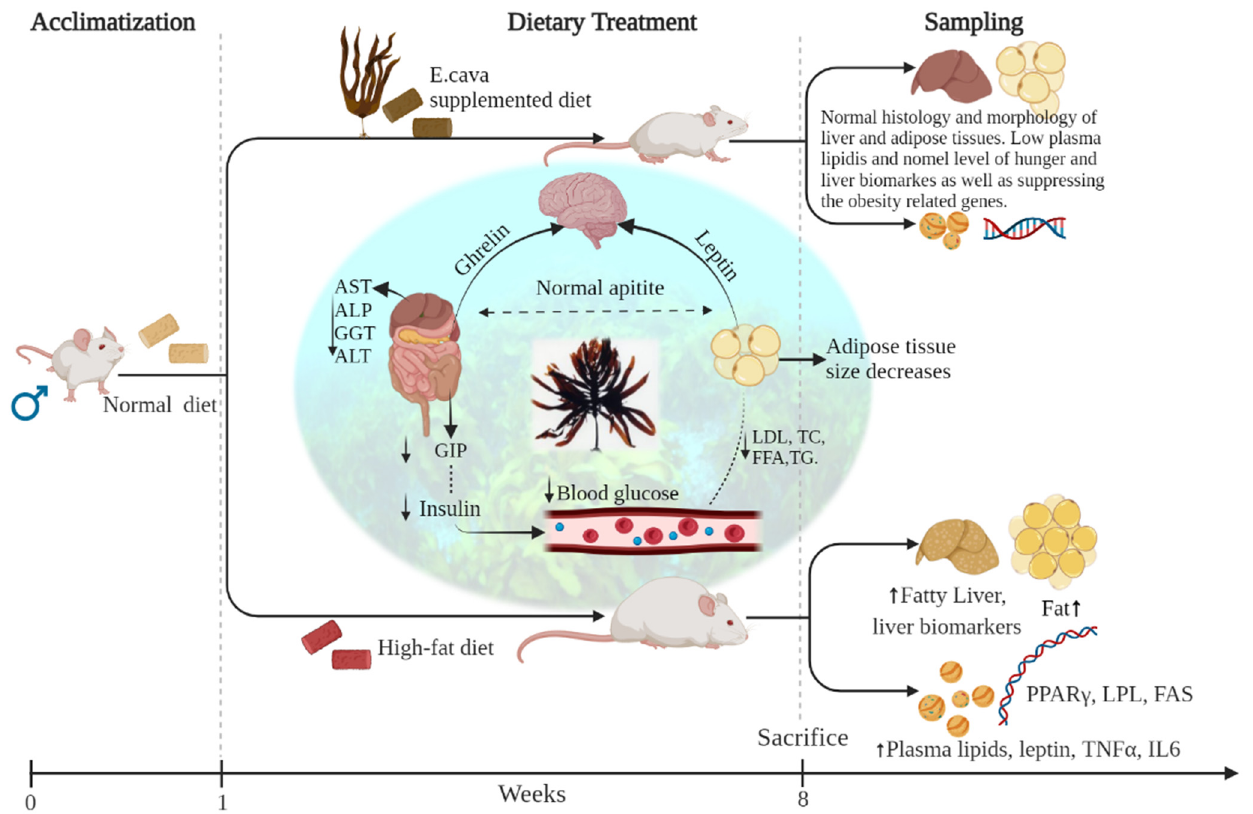
Figure 13. Graphical summary of work represents, in 8 weeks of experiment rats fed with E. cava and HFD. After that, a significant difference was observed in the E. cava -treated groups and the non- treated groups. The impotent parameters such as a change in body weight, organ histology, and blood plasma biomarkers were compared with the treated and the non-treated groups as well as a normal group of rats.